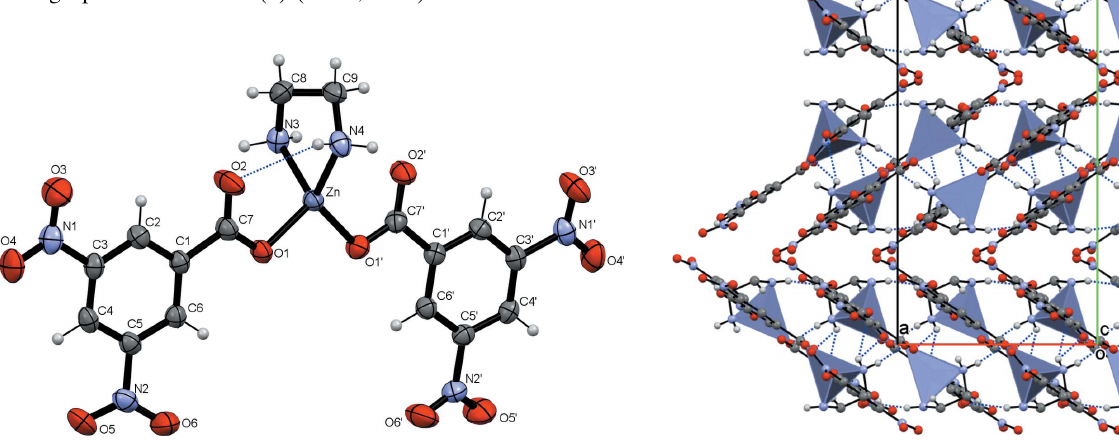
Figure 1 Molecular structure of [Zn(DNBA) 2 (En)] with the atom-numbering scheme. Displacement ellipsoids are drawn at the 50% probability